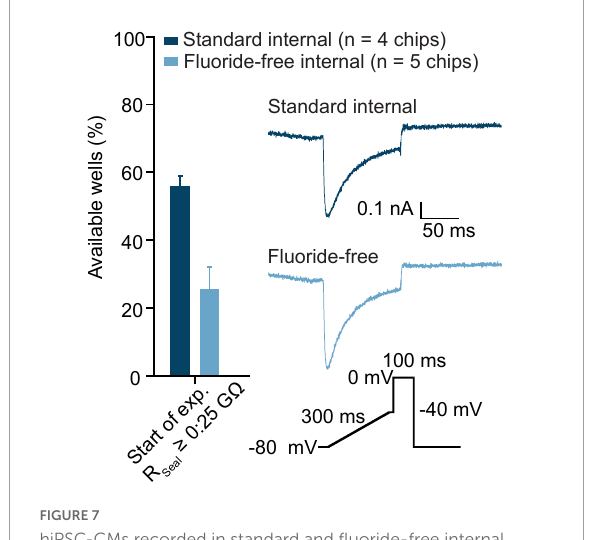
FIGURE7 hiPSC-CMs recorded in standard and fluoride-free internal solution. hiPSC-CMs were captured with almost 60% success rate for R Seal ≥ 0.25 G (cid:127) when using standard internal solution and about 25% R Seal ≥ 0.25 G (cid:127) in fluoride-free internal solution in preliminary experiments. The inset shows an example of a Ca V current recorded from an example cell in standard (top, dark blue) and fluoride-free (bottom, light blue). The voltage protocol used is also shown and only response to voltage step to 0 mV is shown in the raw trace